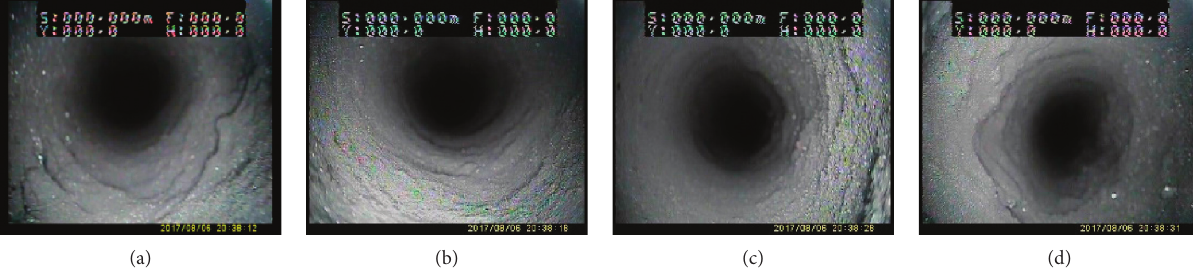
Figure 19: The distribution of the surrounding rock in the roof anchorage area. (a) 0.2m. (b) 0.8m. (c) 1.6m. (d) 2.2m.